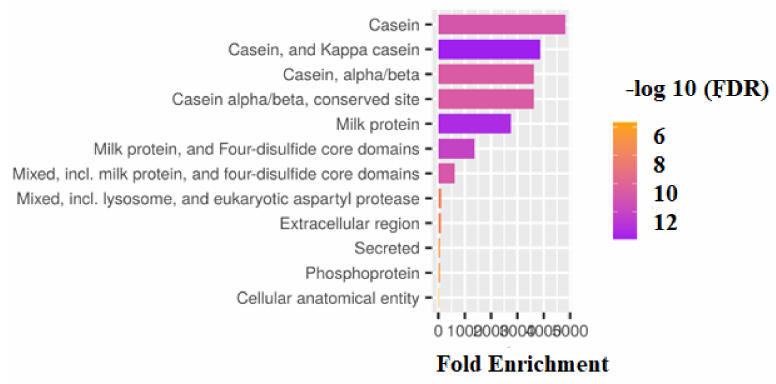
Figure 4. Casein gene enrichment analysis. Using genome sequencing data sets from Camelus ferus , the arrangement of nuclear hormone receptor (NHR) regions in the camel CSN gene family was studied. The camel CSN gene family has a total of 48 NHRs sites (Supplementary Table S3). In particular, there were 13, 16, 8, and 11 NHRs found in CSN1S1, CSN1S2, CSN2, and CSN3, corre- spondingly (Supplementary Table S3). Four inverted repeats (IR) were found in numerous CSN genes that act primarily as hormone response elements (HREs) for steroid receptors. CSN3 included one IR and CSN1S2 contained four IRs, but CSN2 and CSN1S1 lacked IRs (Supplementary Table S3). In camel CSN genes, a total of 17 direct repeats (DRs) and 27 aberrant repeats (ERs) were identified. The distribution of DRs in CSN1S1, CSN1S2, CSN2, and CSN3 was 6, 3, 1, and 7, whereas the distribution of ERs was 7, 10, 7, and 3, accordingly (Figure 5 and Supplementary Table S3). The genetic code patterns of Camelus ferus , Bos tararus , and Ovis aries , as well as the CSN genomic family, were screened for possible transcription factor binding sites using four previously disclosed transcription sites (STAT, GATA, TATA, and OCT1) and the YY1 repressor site. Camelus ferus showed a GATA distribution of 999, 82, 903, and 546 corresponding to CSN1S1, CSN1S2, CSN2, and respectively (Figure 6 and Table S4). In addition, the distribution of TATA sites in Camelus